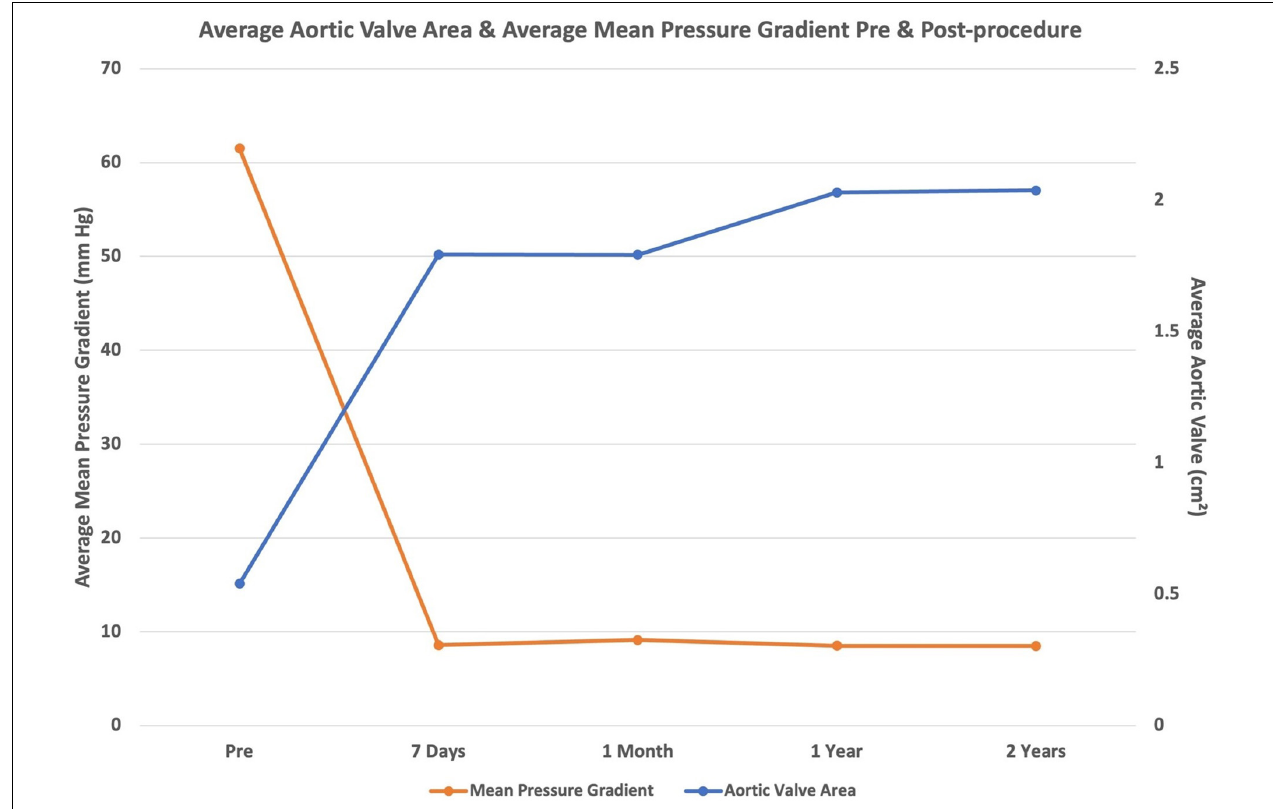
FIGURE 3 | Mean pressure gradient and aortic valve area at 2 years after